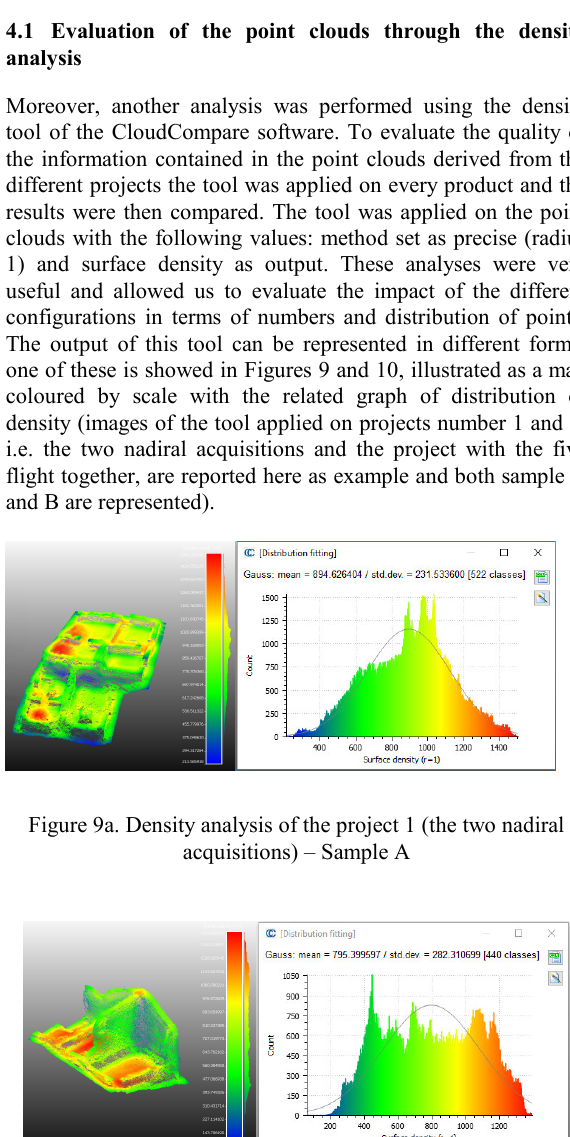
Figure 5. Sample A (left) and Sample B (right)